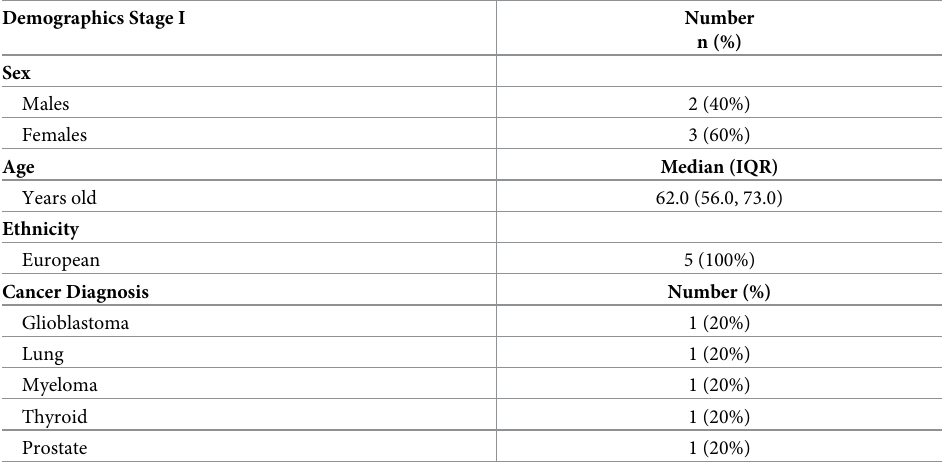
Table 1. Participant baseline demographic and clinical characteristics diagnosed with advanced incurable malig- nancy with controlled pain for Stage I (n = 5